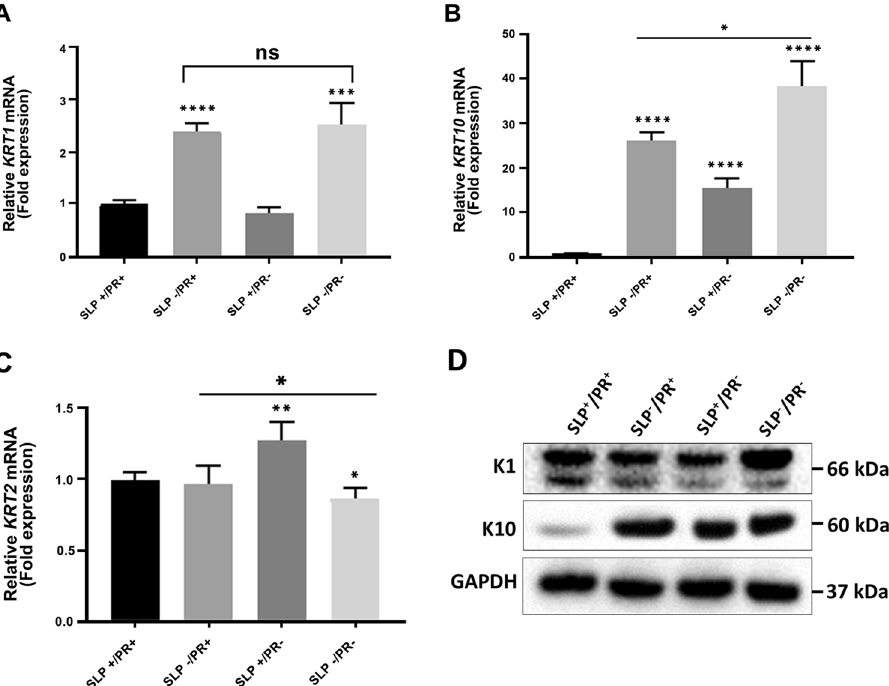
Figure 3. Influence of SLP and PR on mRNA and protein expression of K1, K10 and K2 in HaCaT cells. HaCaT (200,000 cells) were grown in 2 ml growth medium per well of a 12 well plate for 3 days in four different RM + media conditions (SLP + /PR + , SLP − /PR + , SLP + /PR − , SLP − /PR − ) in triplicates for each growth condition. Lysates were collected and analysed for mRNA using qPCR. The mRNA expression data are shown for ( A ) KRT1 , ( B ) KRT10 and ( C ) KRT2 as fold expression normalised to the expression of two housekeeping genes, POLR2A and YAP1 under different growth conditions. ( D ) HaCaT (500,000 cells) were grown in 4 ml growth medium per well of a 6 well plate for 3 days in the above four different RM + media conditions in triplicates for each growth condition. SDS cell lysate containing 20 µ g total protein (measured by Lowry’s method using BSA as standard) was analysed by western blotting for K1, and K10 under different growth conditions. GAPDH was used as a loading control. Relevant bands were cropped from different blots and grouped together. Original blots are shown in Supplementary Fig. S2. Statistical analyses: n = 3, Error bars = SEM, Student’s t-test was performed to calculate p values using Microsoft Excel. One-way ANOVA (shown by a horizontal line over each graph) was used to determine the statistical significance in gene expression between different growth conditions. The p values are given by asterisks (ns = p > 0.05, * p < 0.05, ** p < 0.01, *** p < 0.001 and **** p <